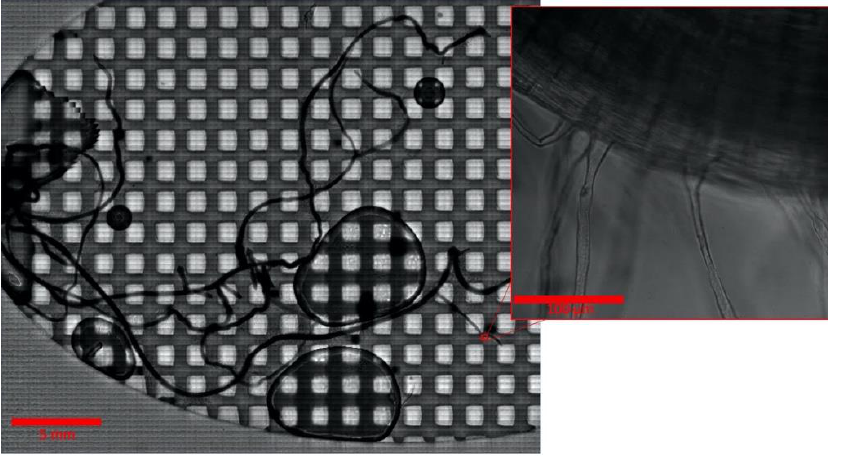
Figure 2. B. distachyon root after 21 days in an Imaging EcoFAB. The whole root is visible at high magnification with a composite scan. Inset is one field of the composite scan.